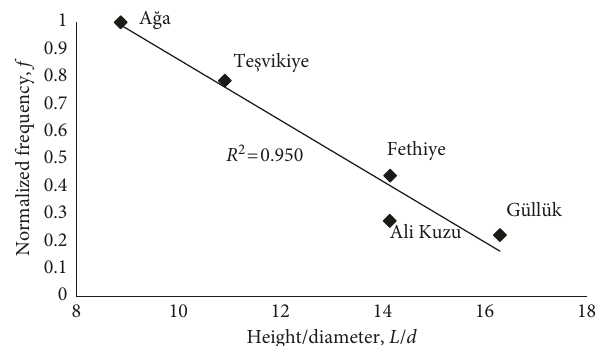
Figure 10: The relationship between the normalized frequencies and heights to diameters.